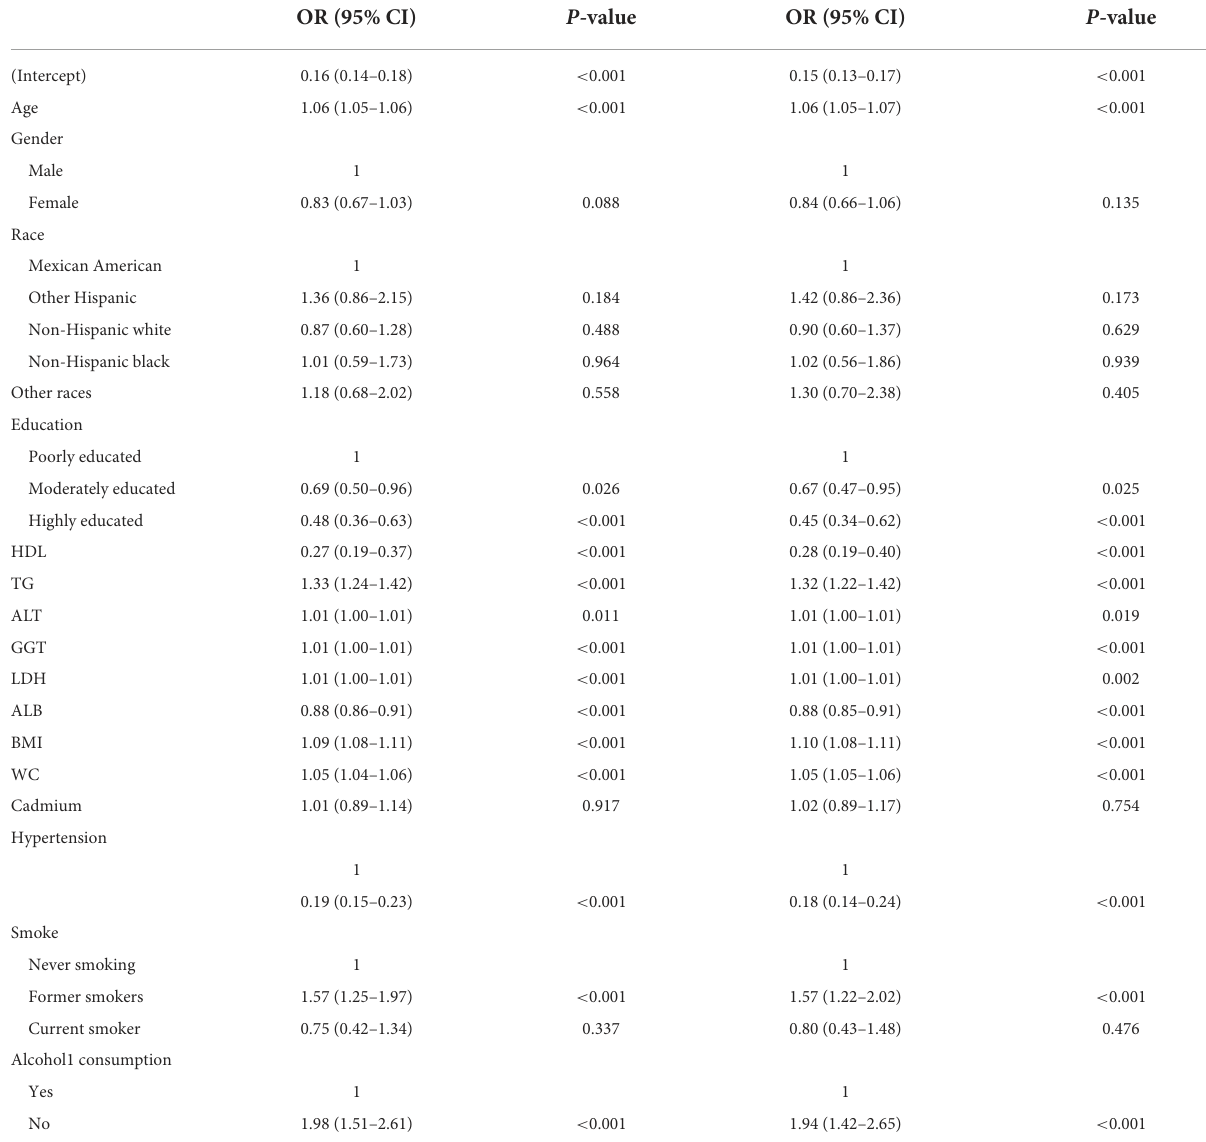
TABLE 2 Univariate logistic regression analysis for diabetes in the low and high cadmium exposure groups, respectively. Univariate logistic regression analysis for diabetes in the low cadmium exposure group